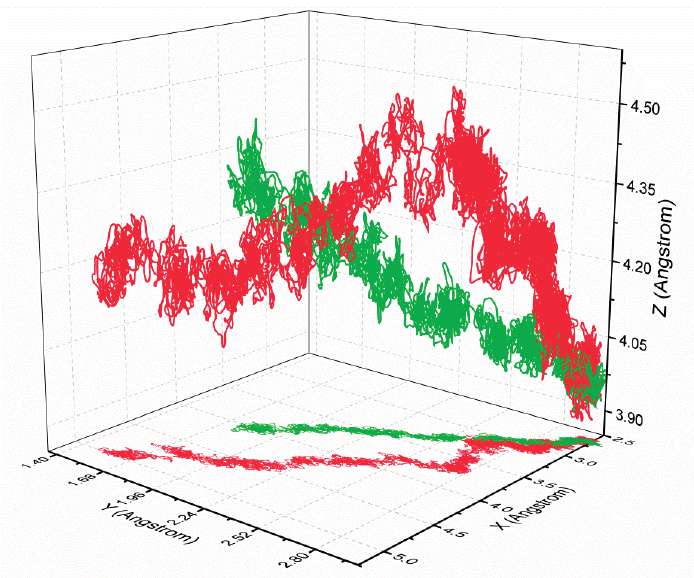
Figure 7. Ligand trajectories of 1d4i with C-SMD (shown in green line) and SA-SMD (shown in red line).